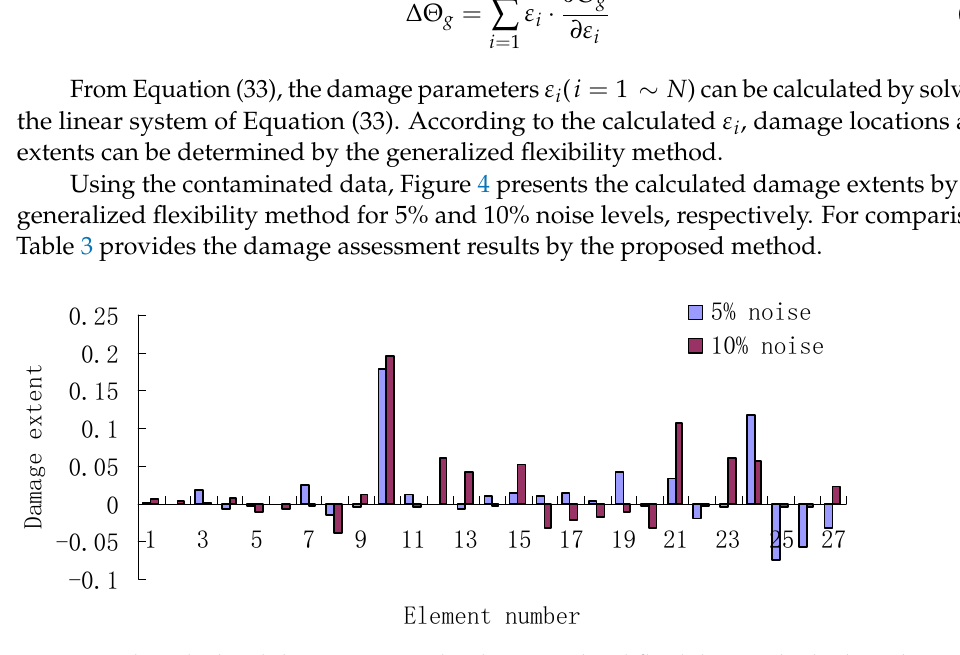
Figure 4. The calculated damage extents by the generalized flexibility method when element 10 is damaged.